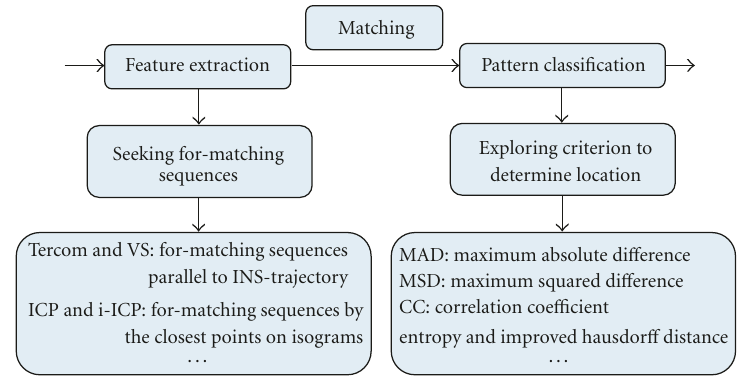
Figure 3: Theoretical frame of the matching process in the viewpoint of pattern